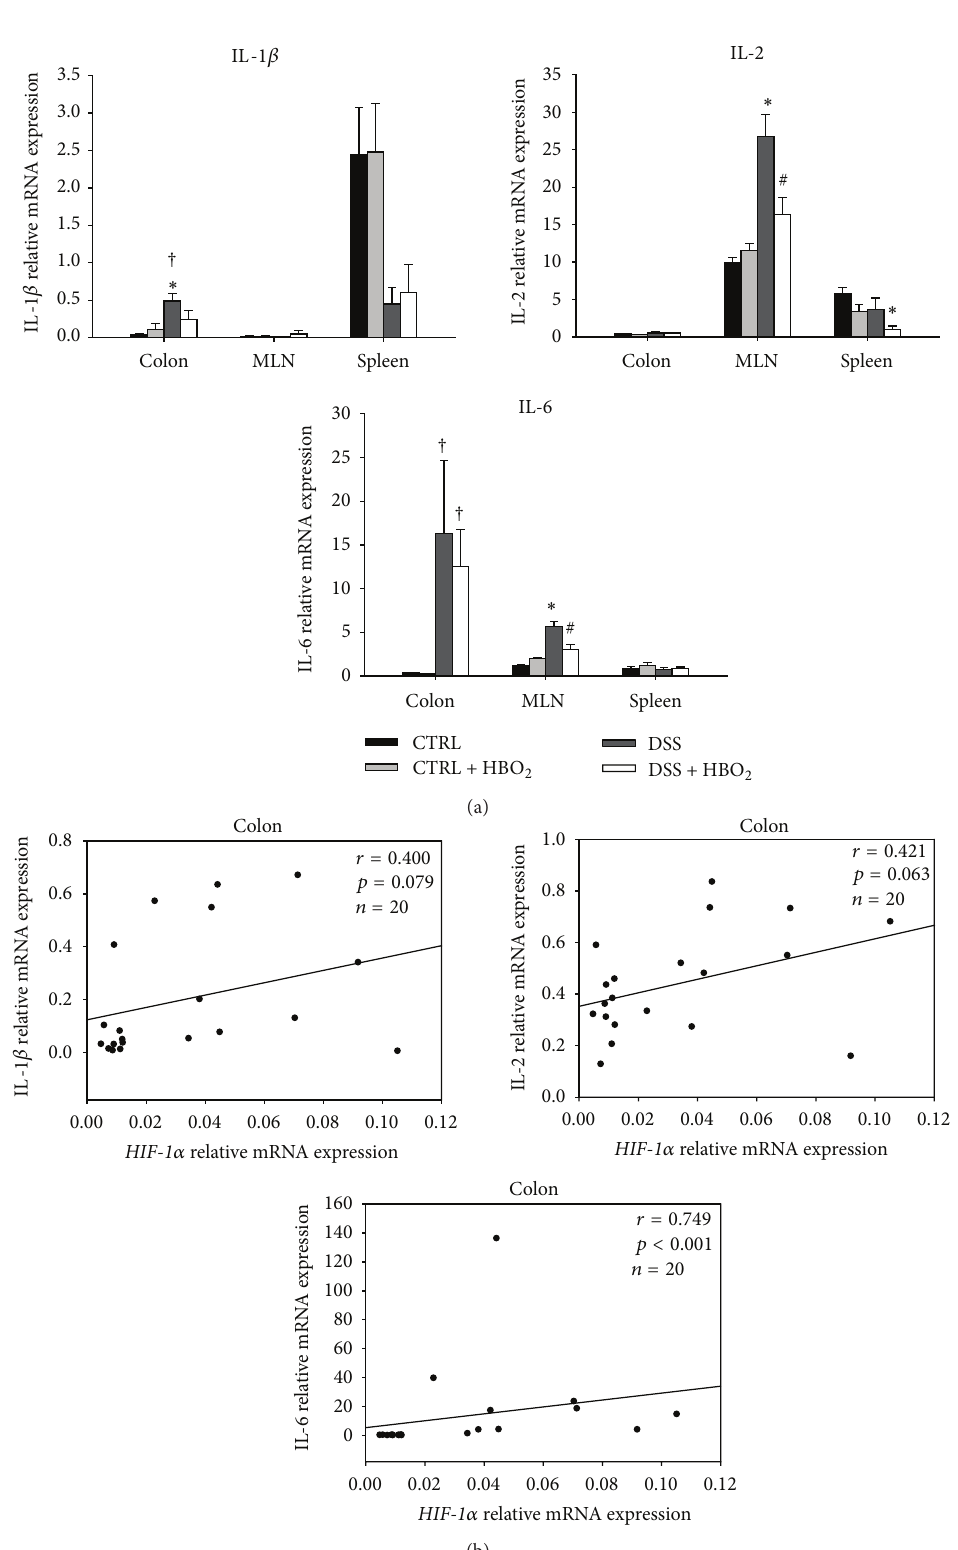
Figure5:RelativemRNAexpressionof IL-1 𝛽 , IL-2, and IL-6 inthecolon,MLN,andspleen(a)andtheircorrelationto HIF-1 𝛼